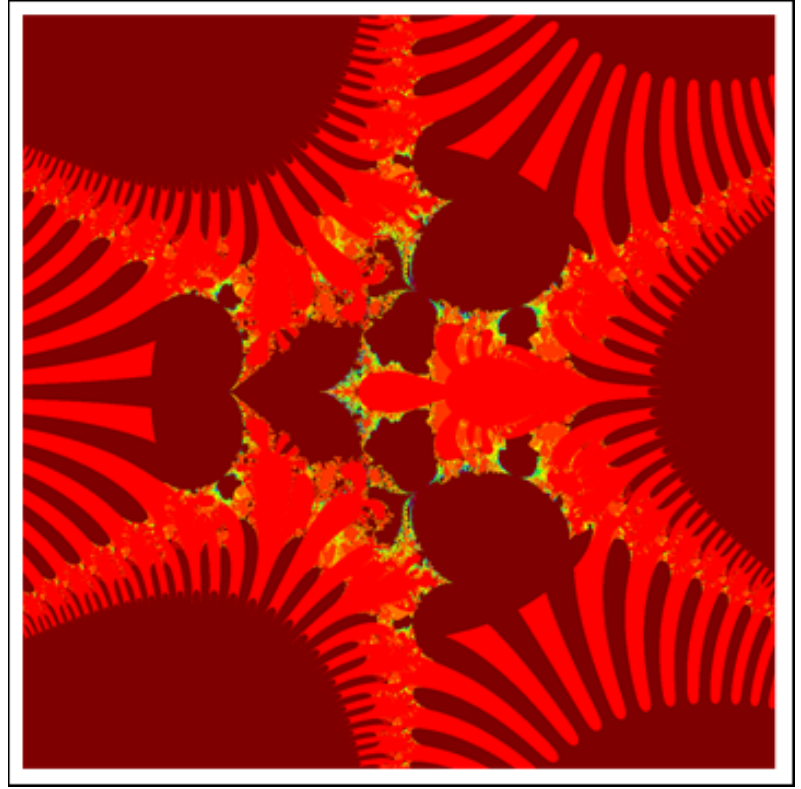
Figure 35. M-set for τ ( z ) = e z 3 + c via DKIS. The image execution time is 804.88